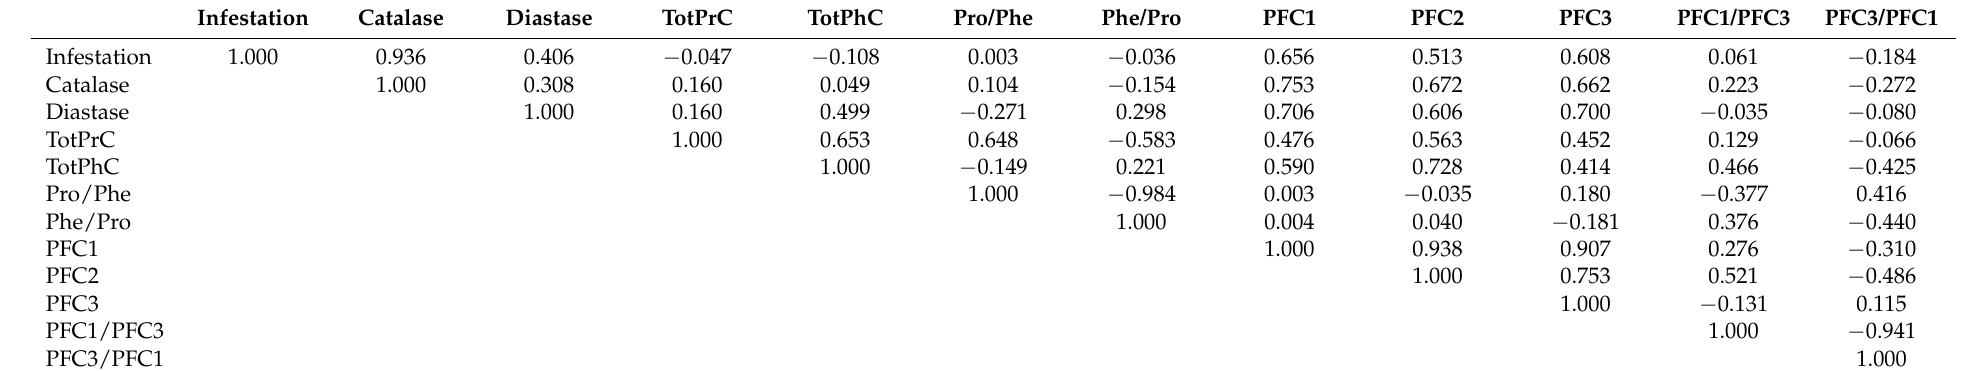
Table 1. Correlation coefficient between infestation with V. destructor , analyzed enzymes, proteins, phenols, and PARAFAC components (under and above the diagonal,